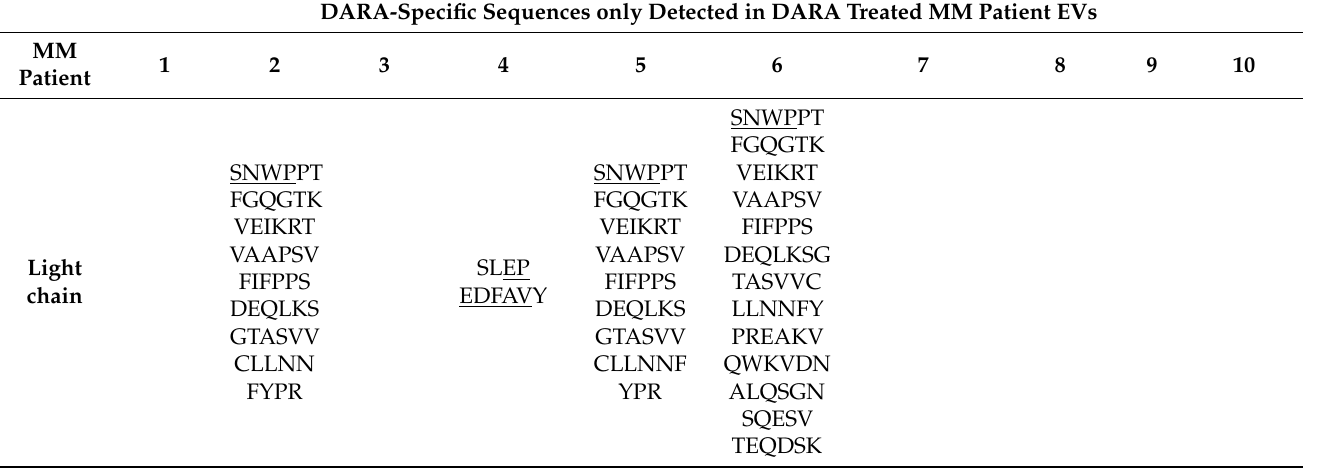
Figure 5. Multiple Myeloma bone marrow EVs have elevated CD59 and CD147 and decreased CD55 and CD9 levels compared to peripheral blood EV, whereas CD38 and PD-L1 are similar across all EV samples. 1.25 × 10 7 EVs/test from 23 matched BM and PB EVs from patients progressing on DARA were bound to the surface of 4 µ m aldehyde/sulfate latex beads and stained with antibodies for; CD9, CD63, CD81, CD147 CD38, PD-L1 and the complement inhibitory proteins CD55 and CD59 for 30 min on ice. The samples were then resuspended in 200 µ L PBS and flow cytometry analysis was performed on a CytoFLEX LX Flow Cytometer. Gating of EV-decorated 4 µ m in diameter beads was performed based on FCS/SSC parameters, so that unbound EVs or possible antibody aggregates are excluded from the analysis. Table 2. Detection of DARA peptide sequences by mass spectrometry on MM PB EVs. DARA-Specific Sequences only Detected in DARA Treated MM Patient